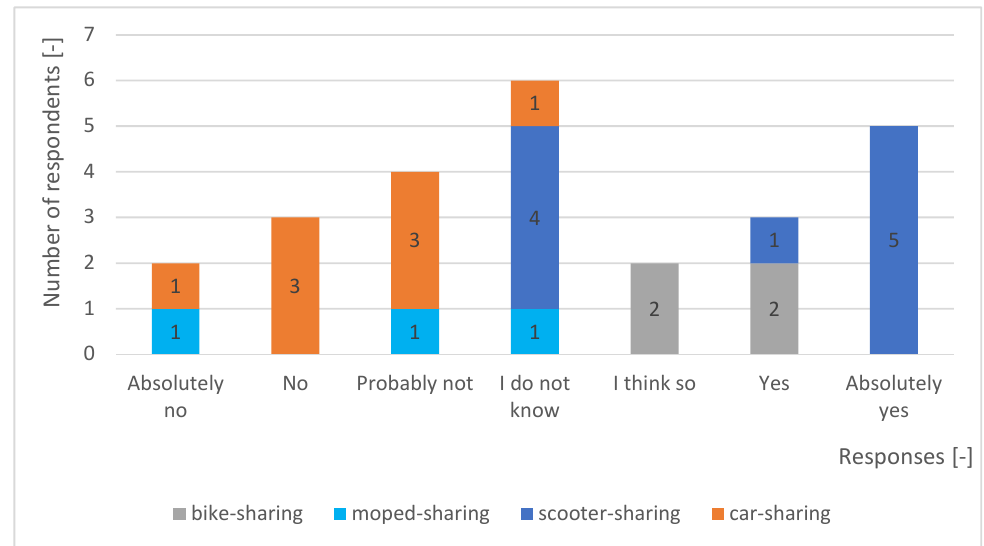
Figure 3. Open innovation enthusiasts in the shared mobility market.